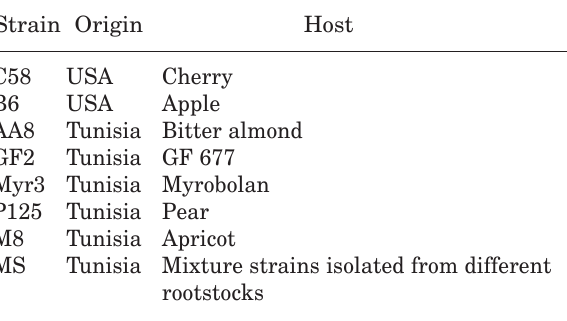
Table 2. Characteristics of the Agrobacterium tumefa- ciens strains used in the